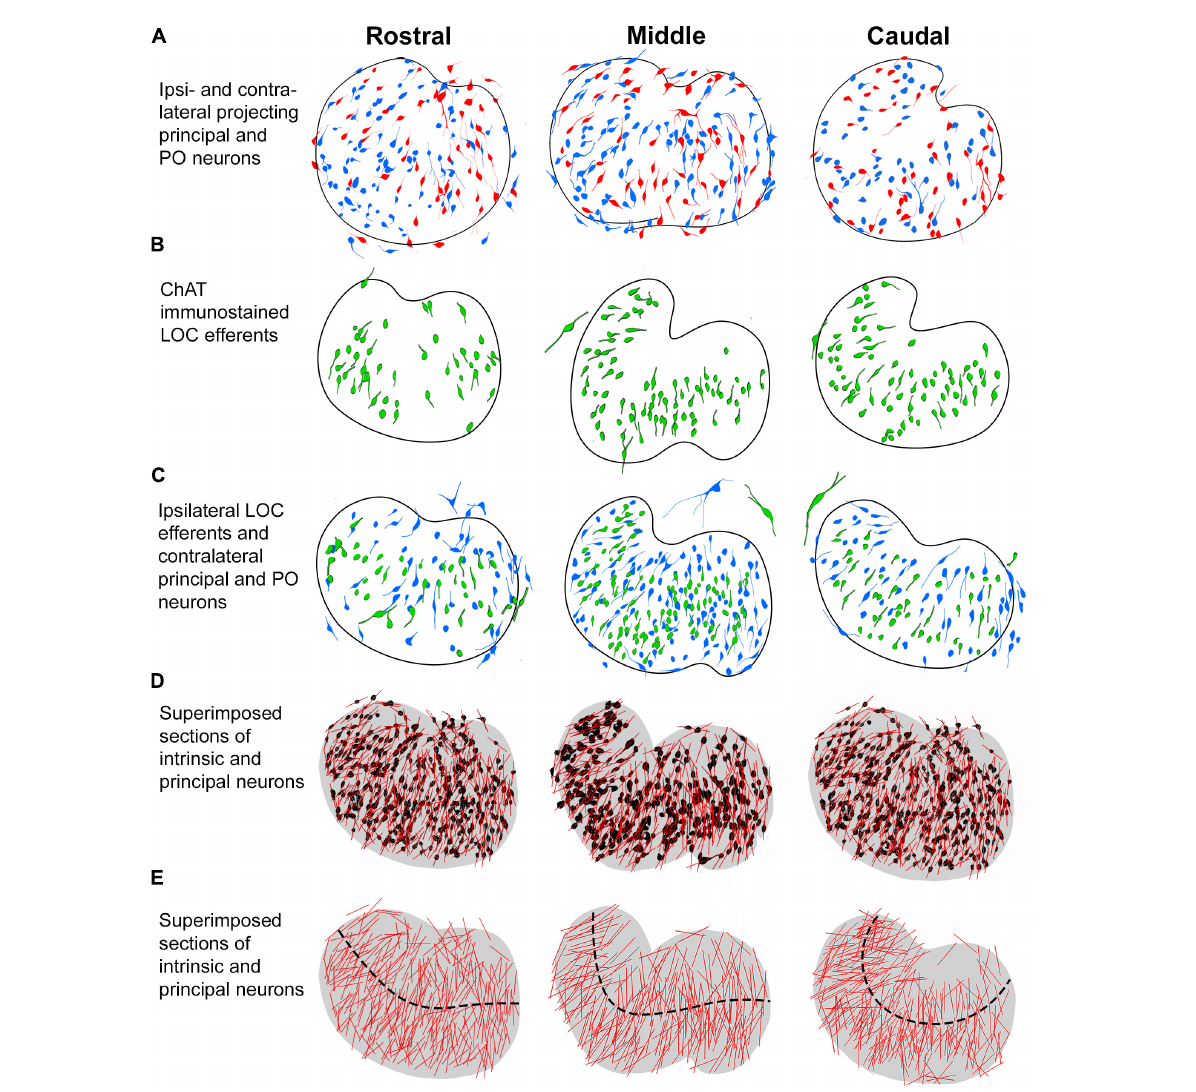
FIGURE8 Summary of labeling pattern of principal and intrinsic neurons in rostral, middle, and caudal LSO sections. The projecting cell types were traced and mapped to illustrate their distribution in representative anterior-posterior regions of the nucleus. (A) Ipsilateral (red) and contralateral (blue) principal neurons labeled from bilateral CNIC injections. (B) Intrinsic efferent neurons labeled by ChAT immunostaining (green). (C) Contralateral projecting principal neurons (blue) and ipsilateral projecting intrinsic neurons (green) labeled by retrograde tracer injections into the CNIC and cochlea, respectively. The larger neurons on the borders of the LSO are identified as the PO and shell neurons [seen in (A–C) ]. (D) LSO neurons with ascending or descending projections labeled from separate LSO sections were superimposed and collapsed as one color (black) on a representative rostral, middle, and caudal LSO section. The somatic long axis line (red) is contrasted against the individual neurons. (E) A model LSO representing rostral, middle, and caudal sections was drawn (gray, fourth row). Here, the relative alignment of principal and intrinsic neurons are shown with the representative tonotopic axis (black dashed line). An overall organization within the nucleus is seen to comprise fibrodendritic laminae. PO, periolivary; LOC, lateral